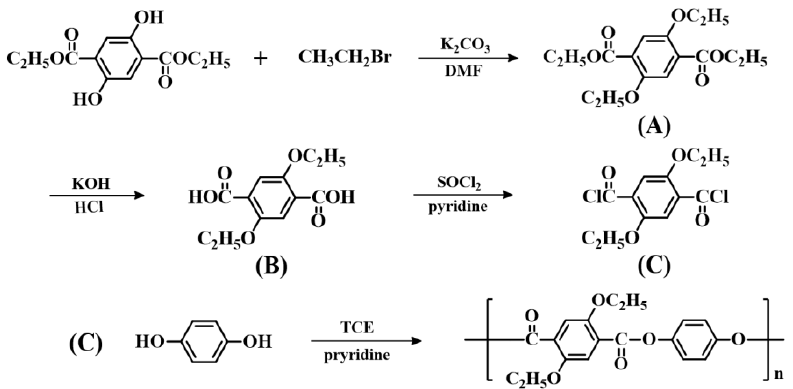
Figure 1. Synthetic routes of the thermotropic liquid-crystalline polymers (TLCPs).